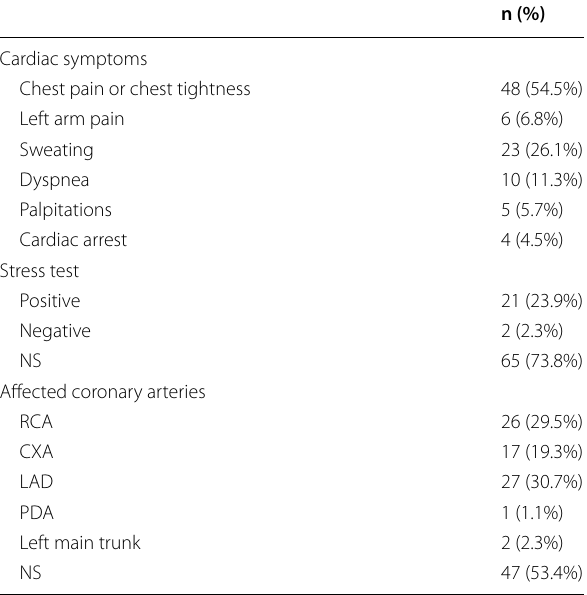
Table 4 Summary of cardiac symptoms, stress test results and coronary arteries affected in patients with cardiac cephalalgia from our review ( n 88) =